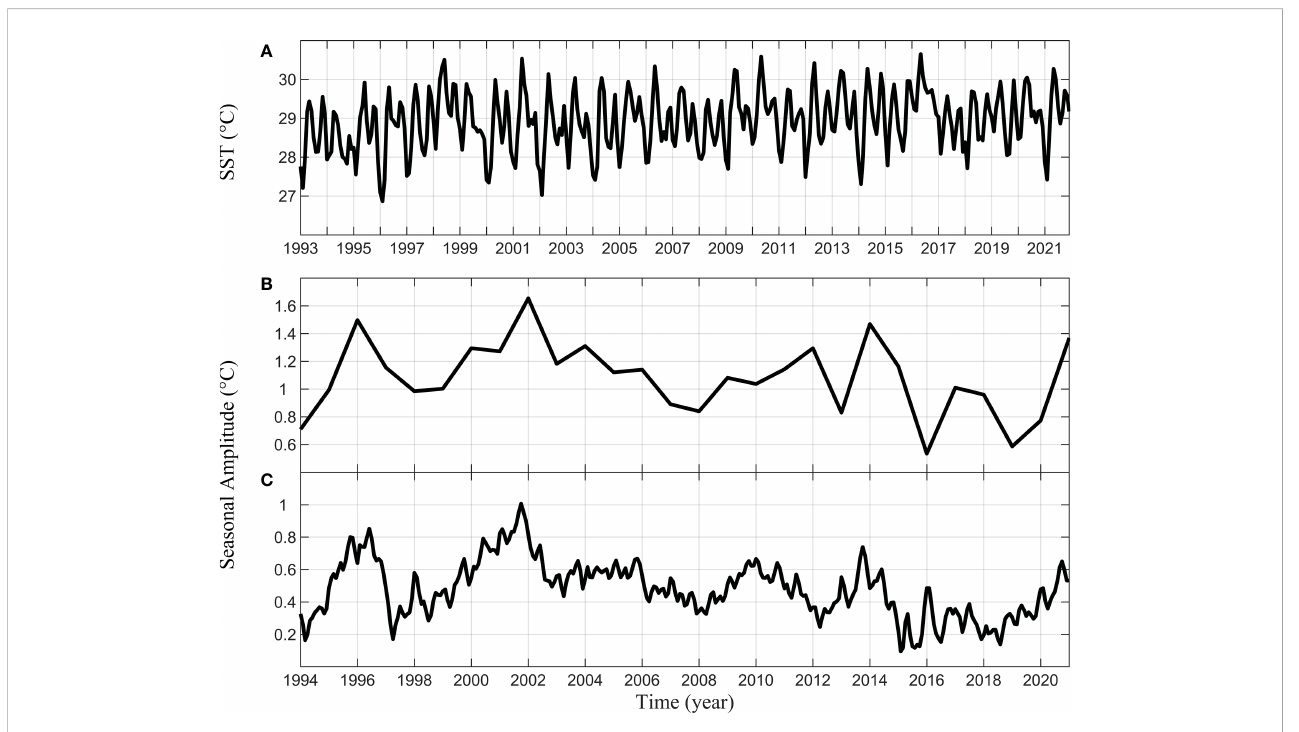
FIGURE 4 (A) Time series of monthly average SST data. (B) The seasonal amplitude of SST obtained by the winter-summer difference algorithm (Method 1), (C) same as (B) but by the harmonic algorithm (Method